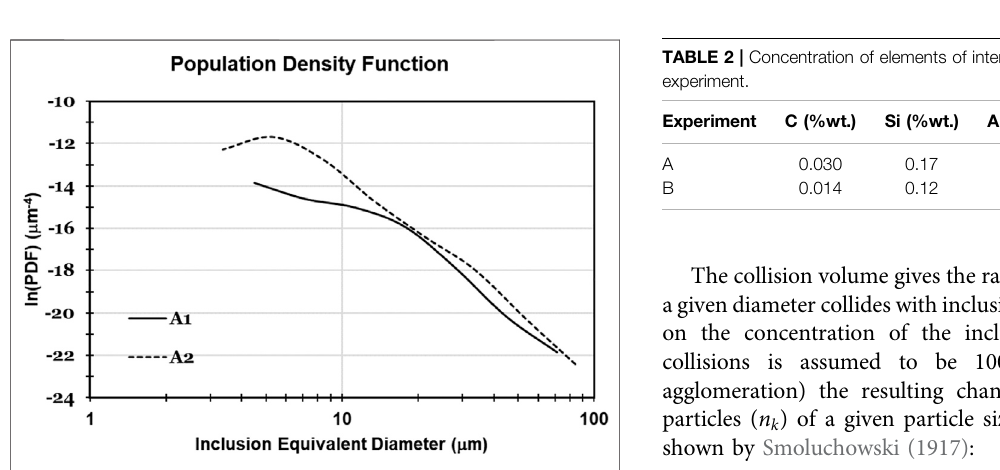
FIGURE 6 | Population density function of inclusions in samples taken 4 minutes before calcium treatment (A1) and 2 minutes before calcium treatment (A2), in experiment A.